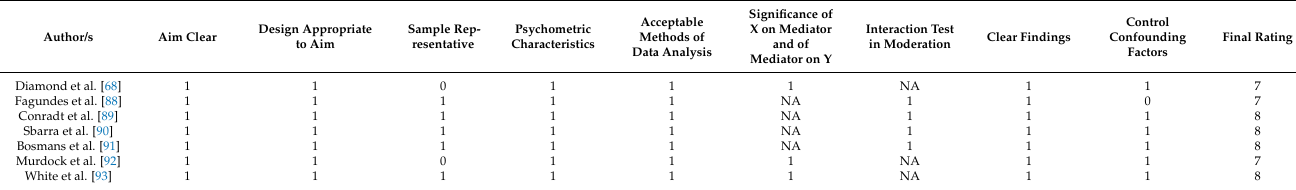
Table 3. Quality assessment of the included